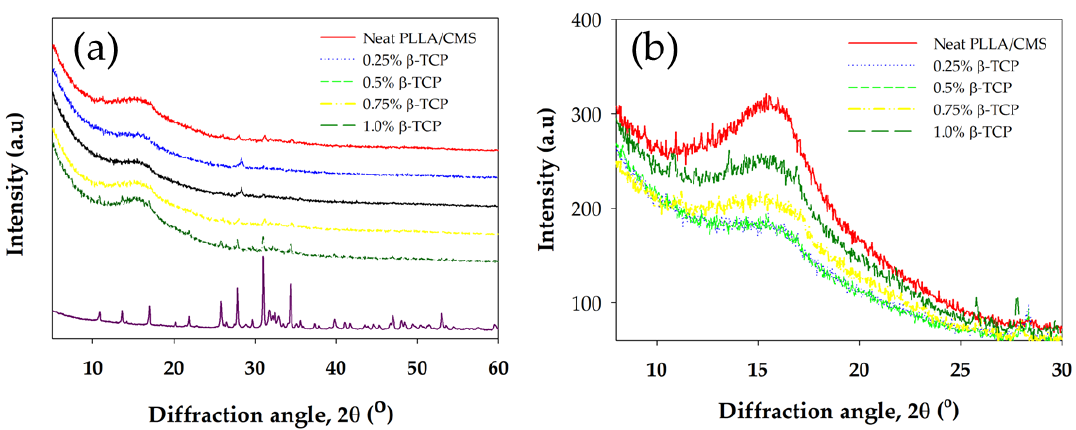
Figure 10. ( a ) X-ray diffraction spectrum for PLLA/CMS/β -TCP composite nanofibers at the different components of β -TCP ( b ) Different intensity of XRD peak at [110] PLLA plane.